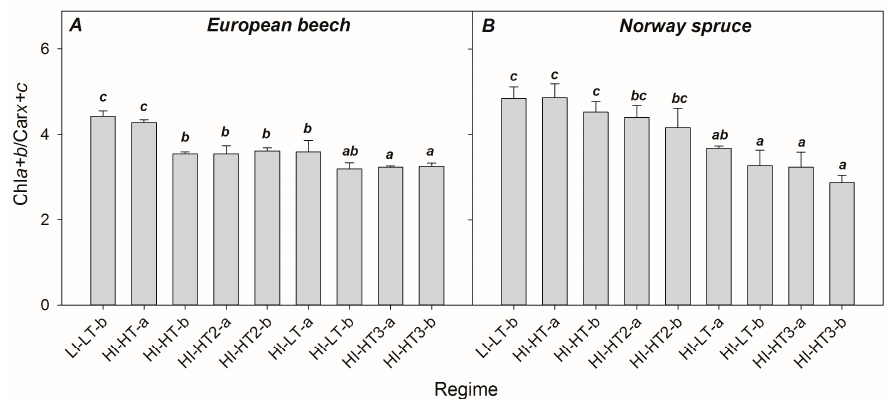
Figure 3. Total chlorophyll/carotenoid ratio (Chl a+b /Car x+c ) in European beech ( A ) and Norway spruce ( B ) saplings in response to five consecutive regimes of irradiation and temperature (LI–LT, HI–HT, HI–HT2, HI–LT, and HI–HT3). Lowercase letters in the regime labels indicate data from measurements at the beginning (a) and end (b) of acclimation to the given regime. Means (columns) and standard deviations (error bars) are presented ( n = 3). Letters above the bars indicate homogeneous groups ( p < 0.05; Tukey’s post hoc test), different letters represent statistically-significant differences between means.